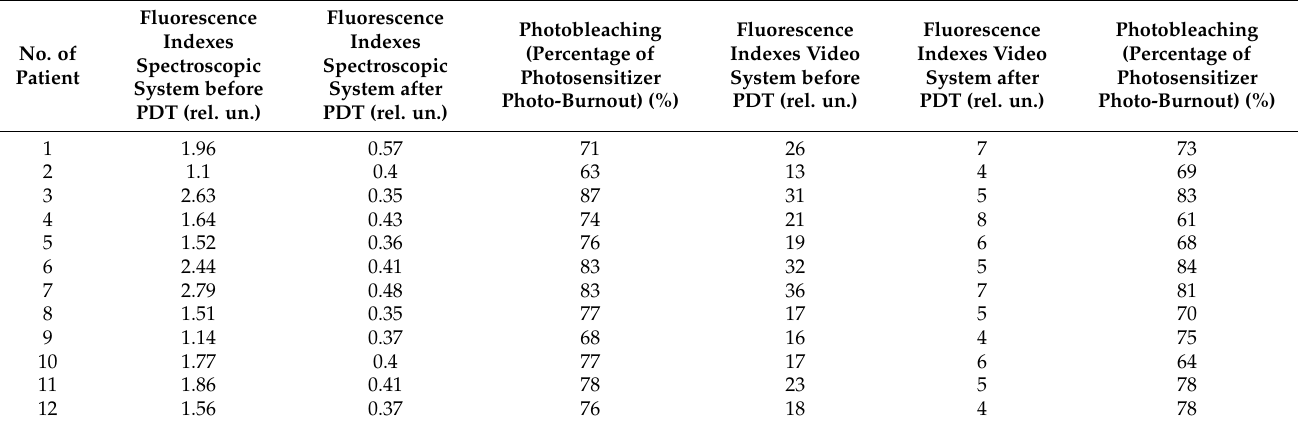
Table 1. The value of the fluorescence indexes of each patient obtained by different methods before and after